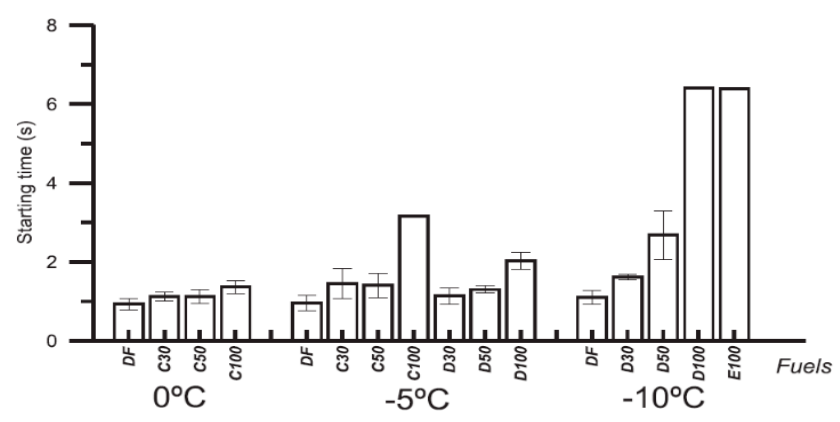
Figure 9. Starting time of engine for various biodiesel blends [50].